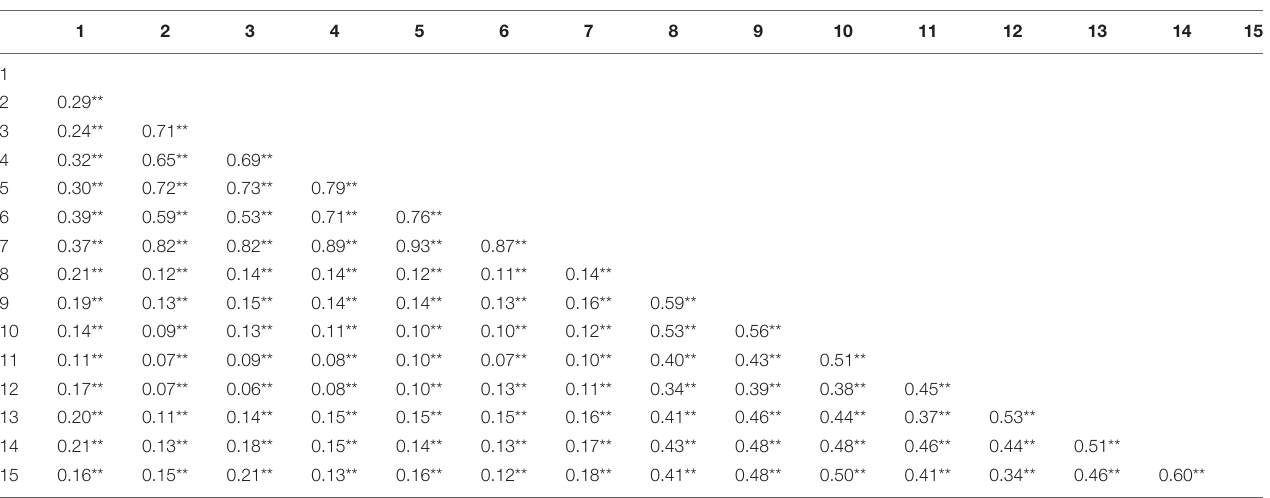
TABLE 3 | Analysis of correlations between emotional dependence, addictive behaviours, and received